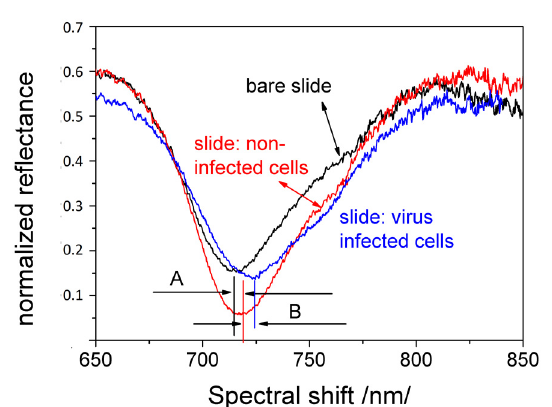
Figure 2. Experimentally observed resonances of bare grating and cell-based SPR assays.